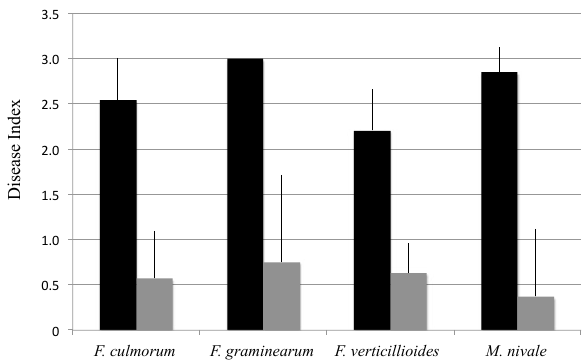
Figure 2. Mean crown rot disease indices after Paenibacil- lus polymyxa SGK2 inoculation of wheat seedlings. Durum wheat seedlings were either infected by the fungal patho- gen (black bars), or inoculated by the fungal pathogen and the P. polymyxa SGK2 strain (grey bars). The disease indices ranged from 0 (no disease) to 3 (maximum disease with crown infection surface ≥ 50 %). Standard deviations of the means are indicated. Friedman test showed a global difference ( P <0.046) between treatments with or without inoculation with P. polymyxa SGK2 strain. (Figure 3). F. culmorum reduced root dry weight by